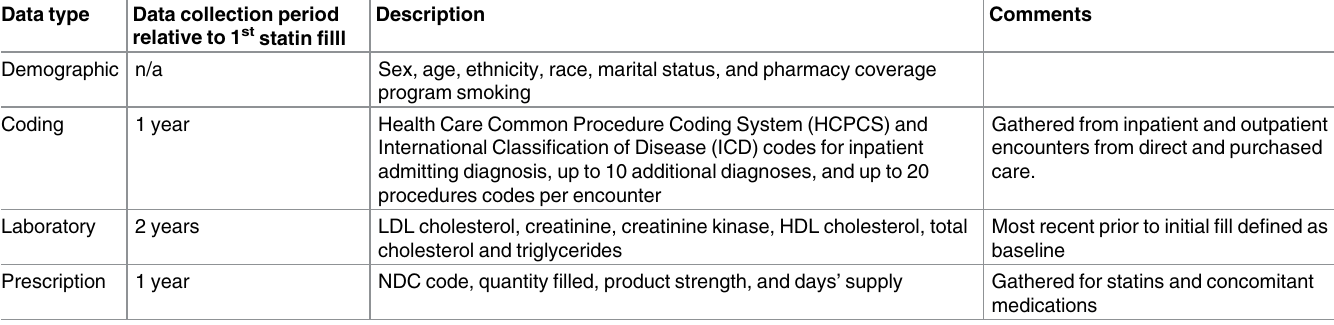
Table 1. Electronic health record (EHR) data collected from each patient prior to 1 st statin